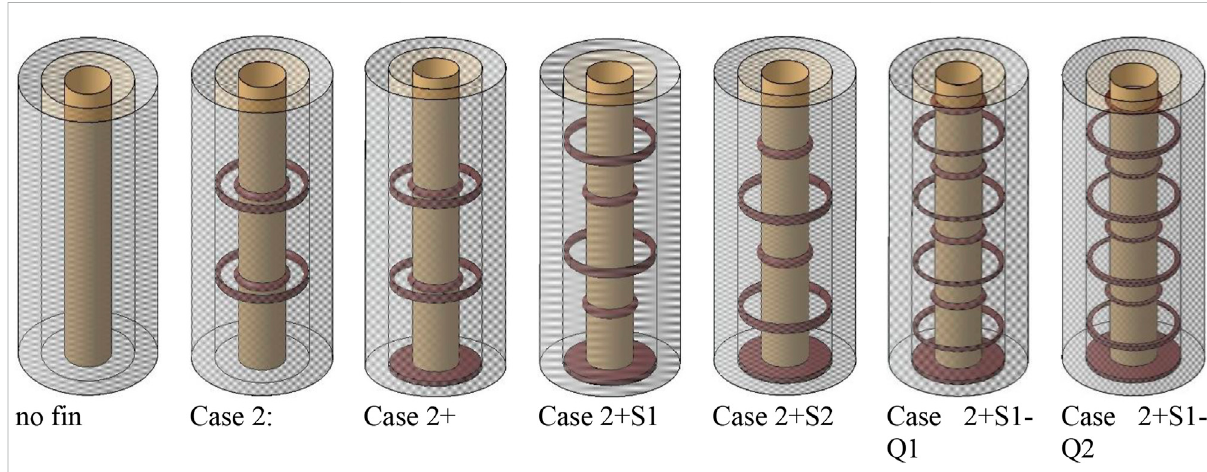
FIGURE 3 Allthestudiedcon fi gurations including, fi nlesscase, inlinecase,inlinecasewithanadded fl at fi n,left-andright-staggered fi ns,andupwardand downward curve view